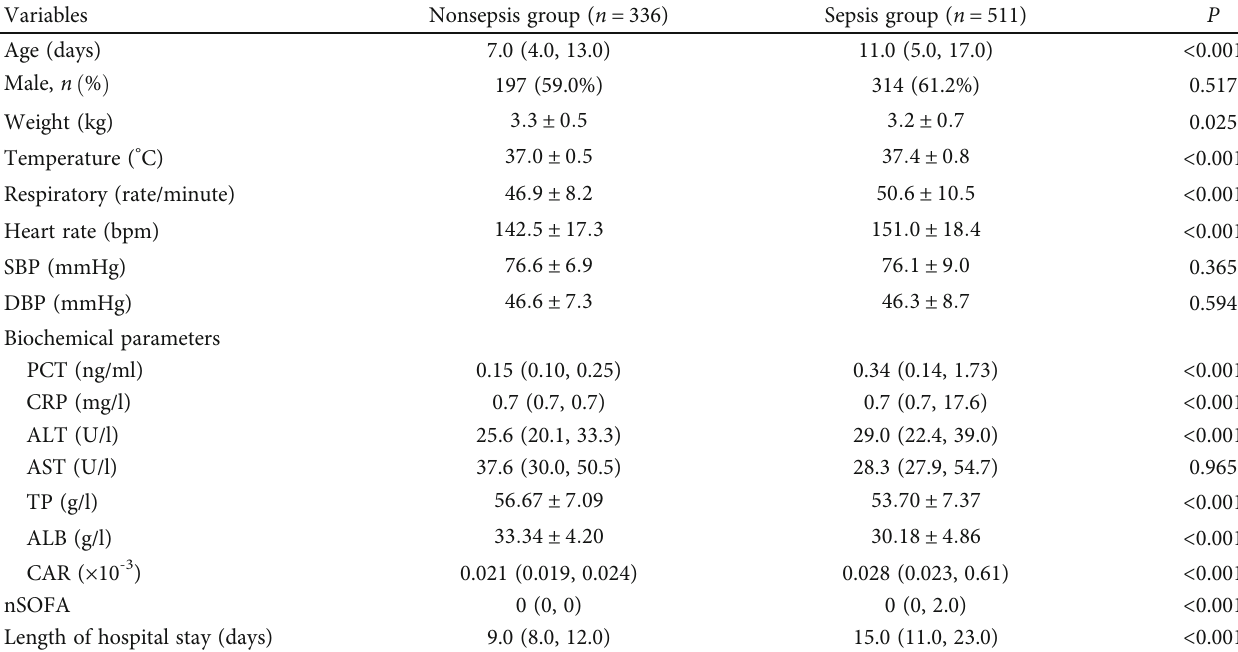
Table 1: Basic characteristics of study subjects by